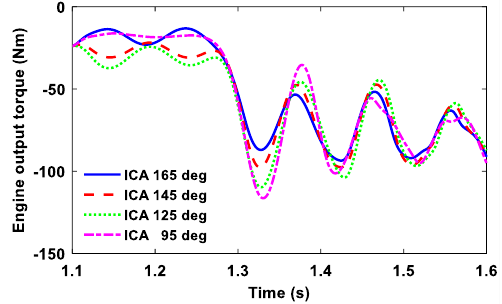
Figure 11. Effect of ICA on engine output torque with θ ivct = 150 deg.